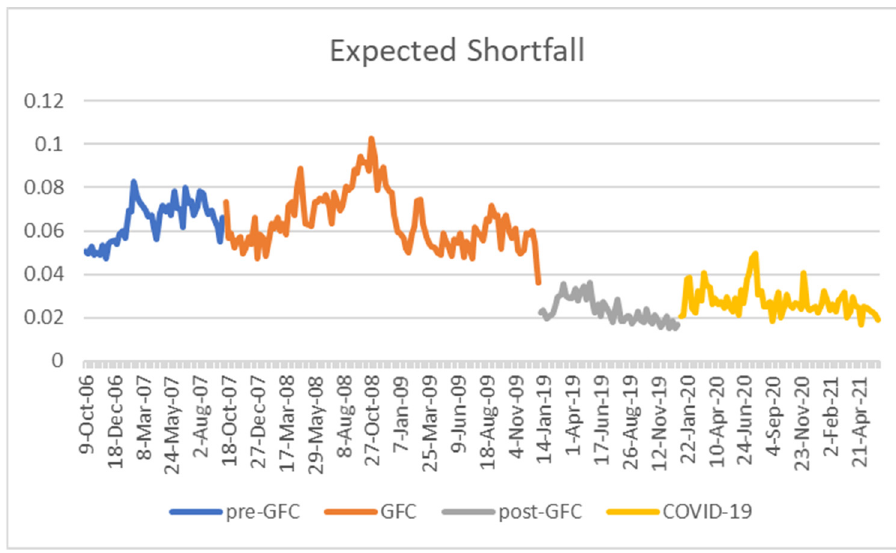
Figure 1. Expected shortfall of portfolios in four